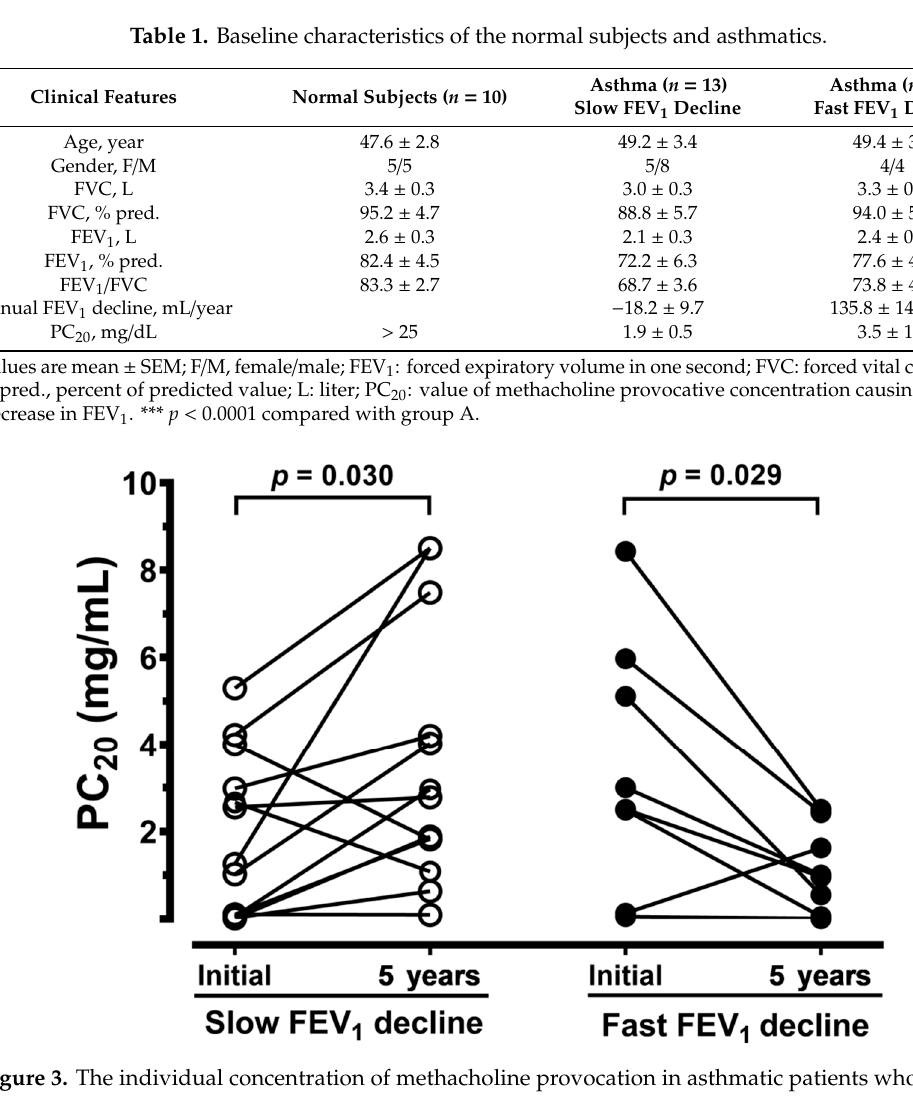
Table 1. Baseline characteristics of the normal subjects and asthmatics.